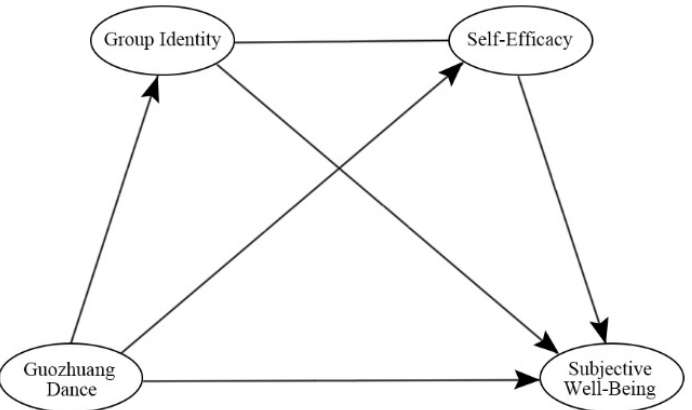
Figure 1. Research